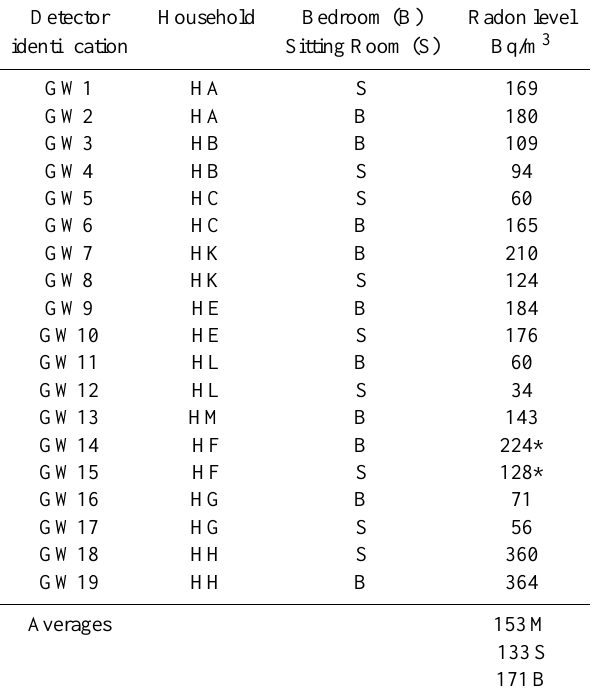
Table 2. Radon levels in Hamadan buildings during the winter sea- son for 85 days. The bottom line shows averages for sitting rooms (S), bedrooms (B) and the overall average (M). Double glazed prop- erty marked with a